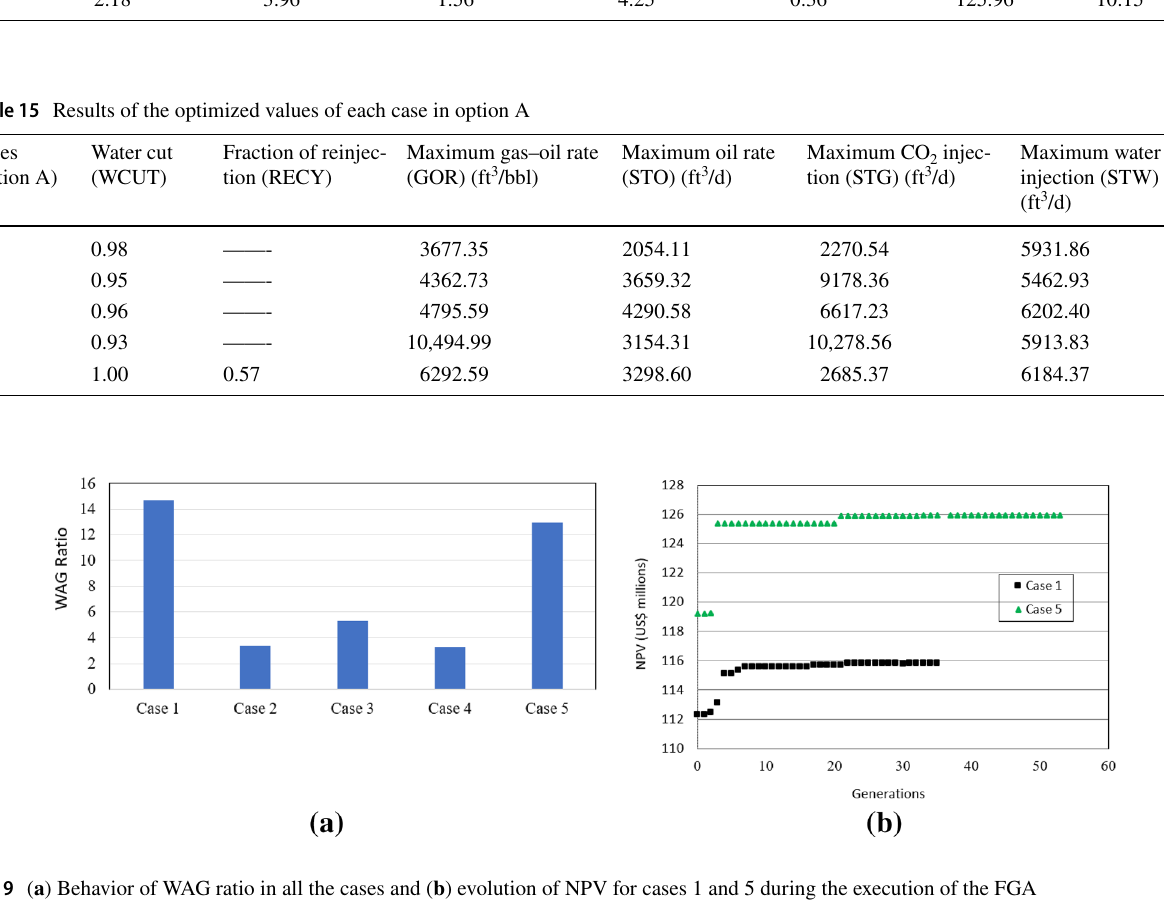
Fig. 9 ( a ) Behavior of WAG ratio in all the cases and ( b ) evolution of NPV for cases 1 and 5 during the execution of the